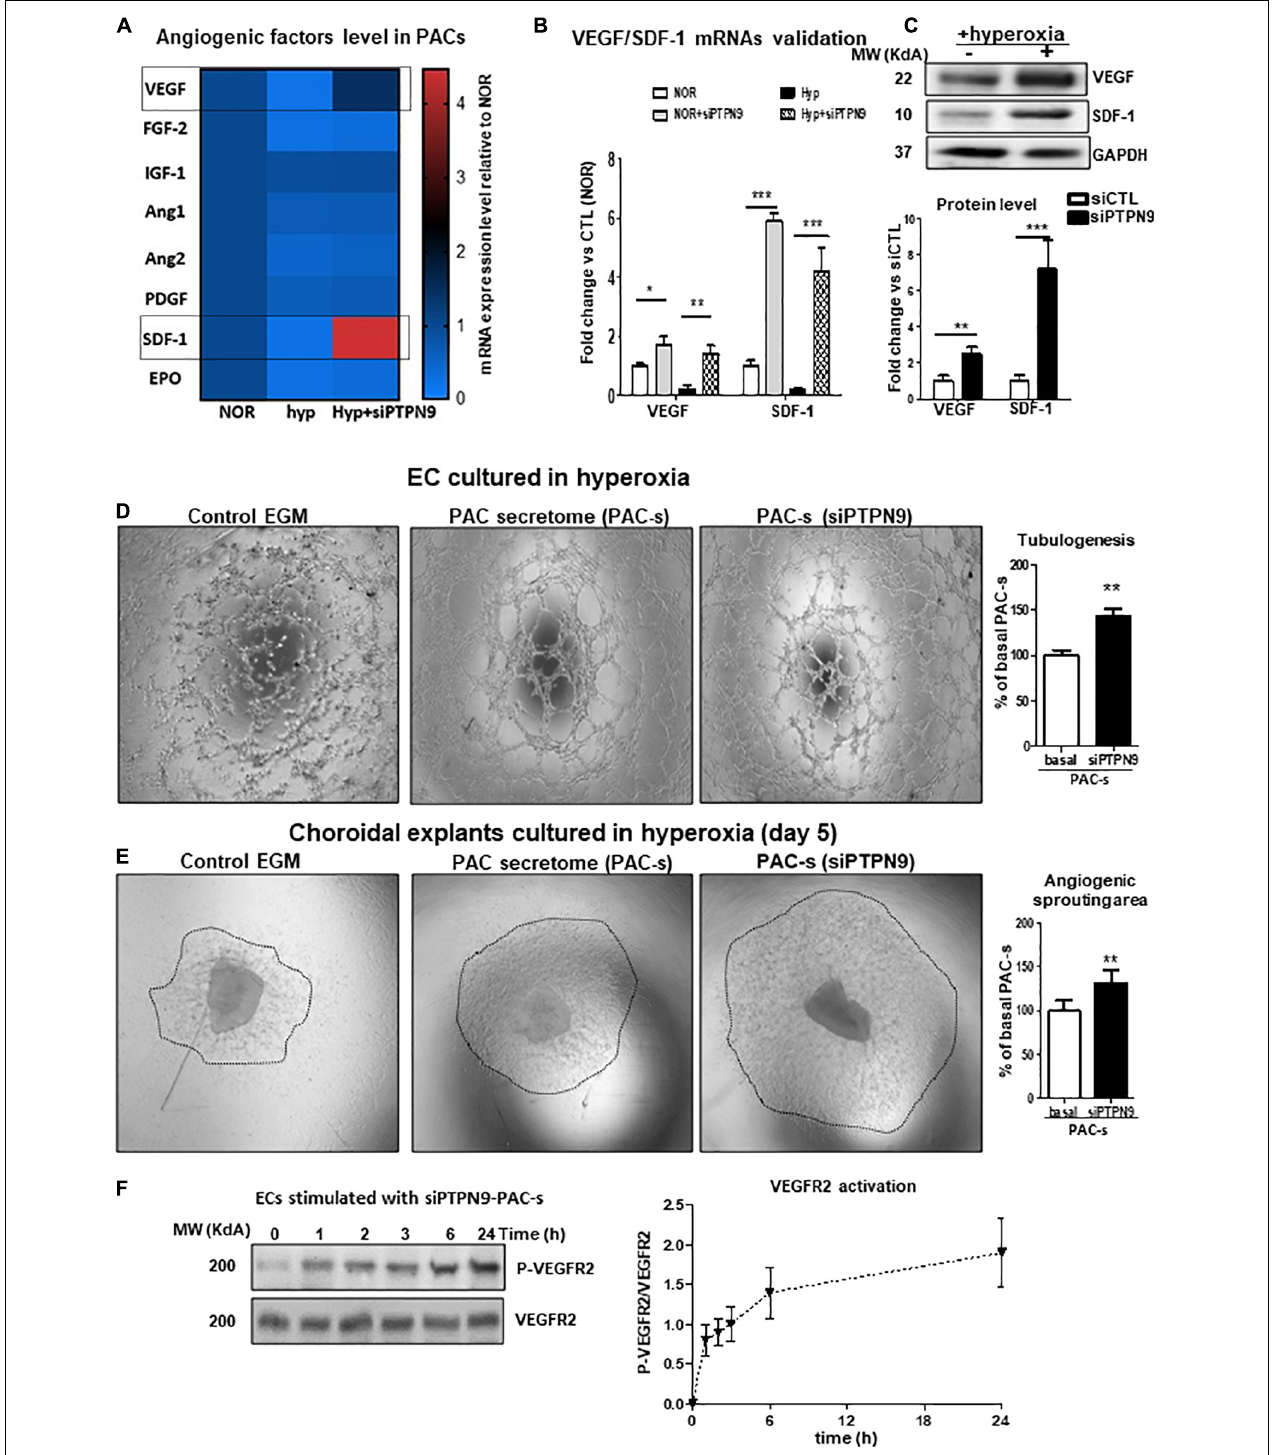
FIGURE 4 | PTPN9 negatively regulates the angiogenic properties of PACs, and PTPN9-silencing protects against hyperoxia-induced PAC dysfunction. (A) mRNA analysis of angiogenic factor expression rescue by PTPN9 silencing in PACs subjected to hyperoxia. (B,C) qRT-PCR (B) and western blot (C) validation of the beneficial effects of PTPN9 silencing on SDF-1 and VEGF expression. (D–F) Comparison of the effects of siPTPN9-treated-PAC-s, PAC-s and EGM on HMREC tubulogenesis (D) and choroidal explant angiogenic sprouting (E) in hyperoxic condition. (F) Time course analysis of VEGFR2 phosphorylation state in HMRECs treated with siPTPN9-PAC-s under hyperoxic conditions. N = 3–4 experiments. * P < 0.05 or ** P < 0.01 or *** P < 0.001 vs. respective control (NOR or hyp or basal).